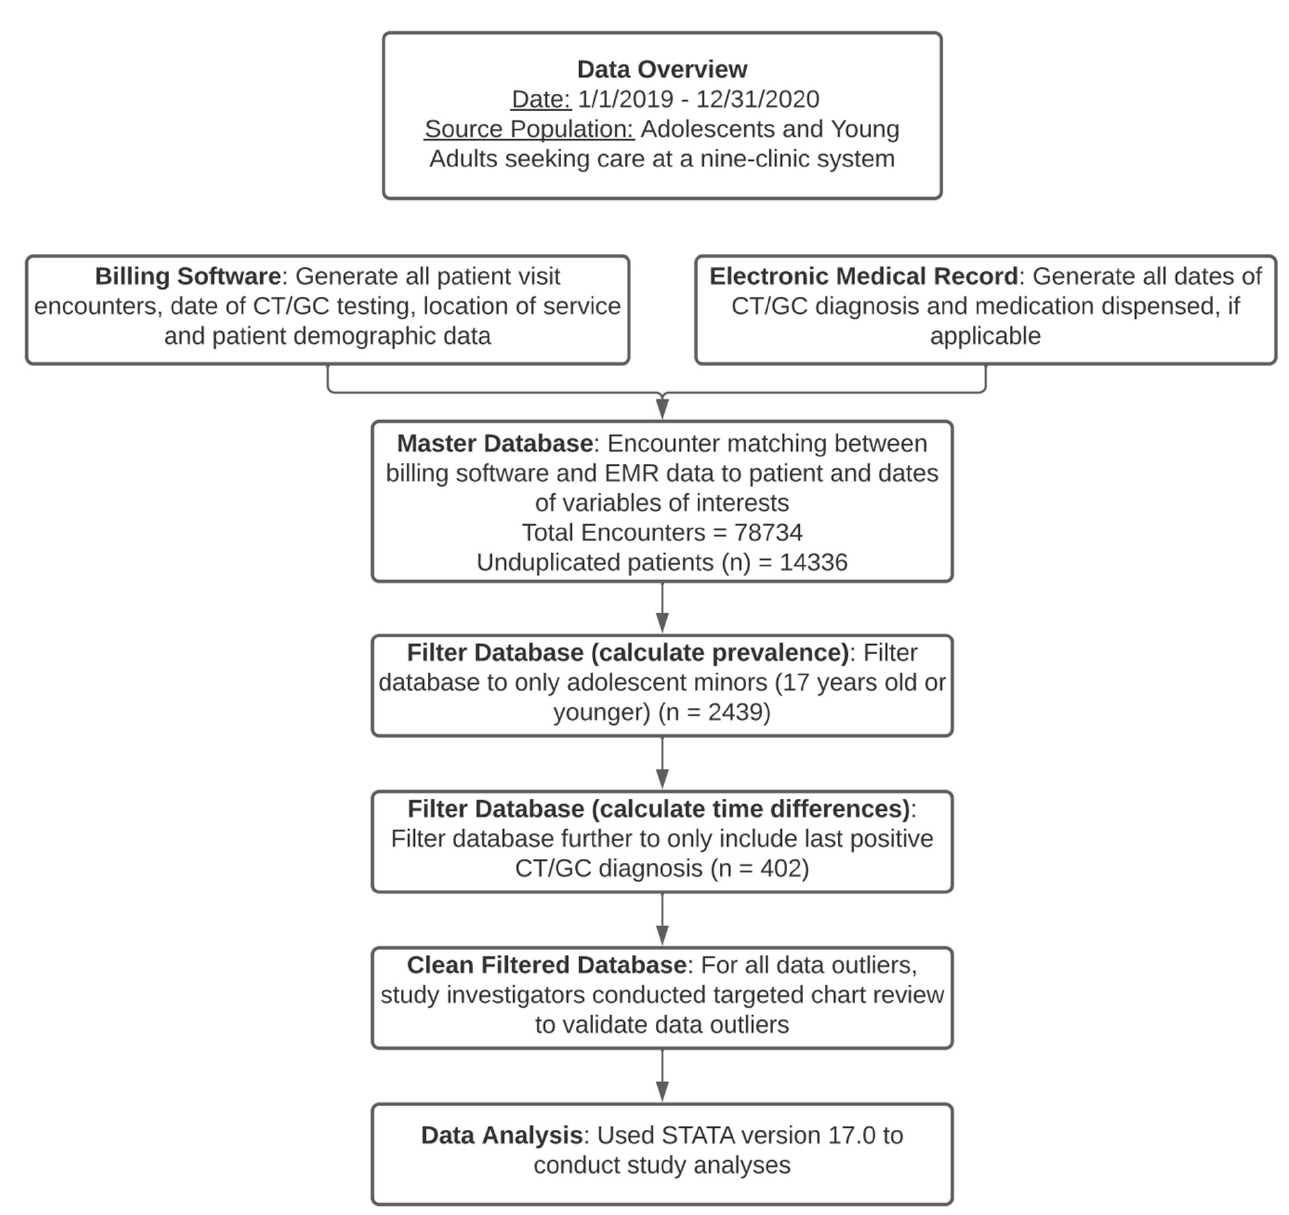
Figure 2. Dataset Preparation.